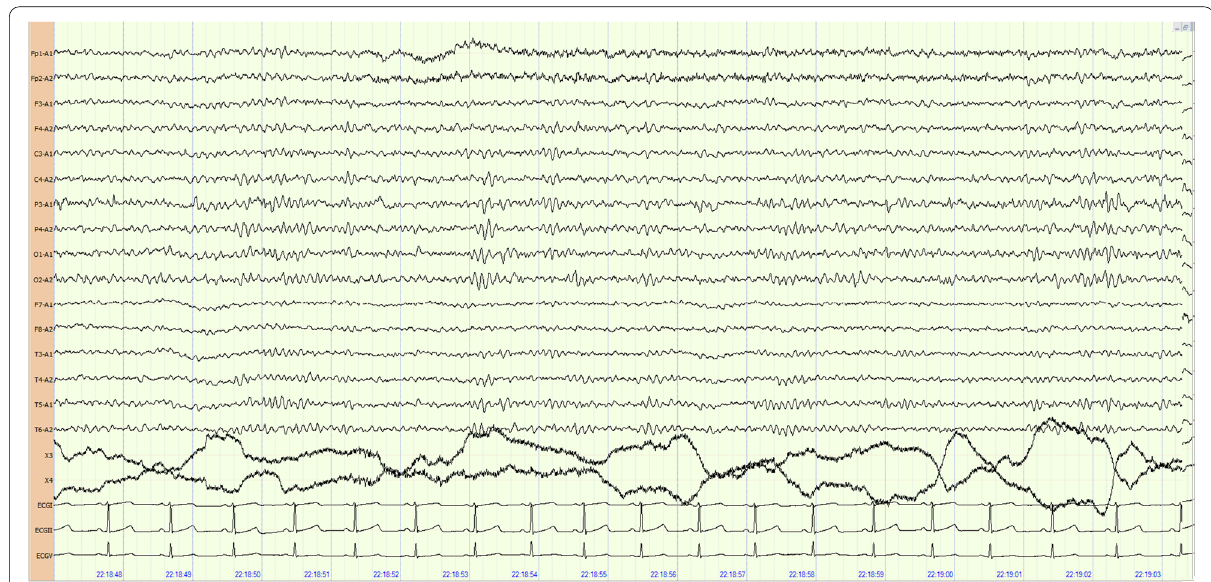
Fig. 1 Electroencephalographic background the electroencephalogram was recorded in a quiet state when the patient was awake, with eyes closed, on the background of 9–10 Hz and 10–50 μV α wave. The EEG background was